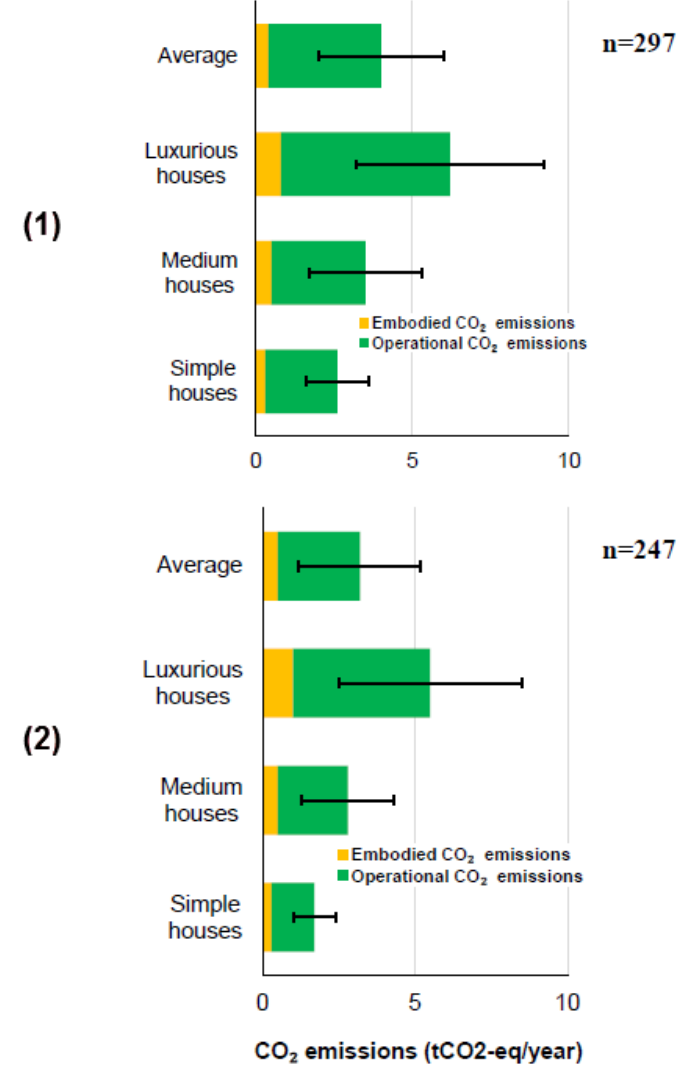
Figure 10. Average annual life cycle CO 2 emissions for respective house categories in ( 1 ) Jakarta and ( 2 ) Bandung for Scenario